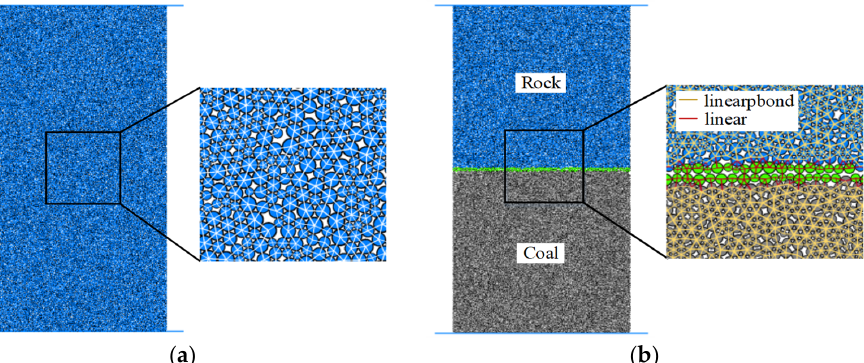
Figure 1. PFC2D numerical calculation model. ( a ) Rock, coal numerical model. ( b ) Coal–rock combination numerical model [9].